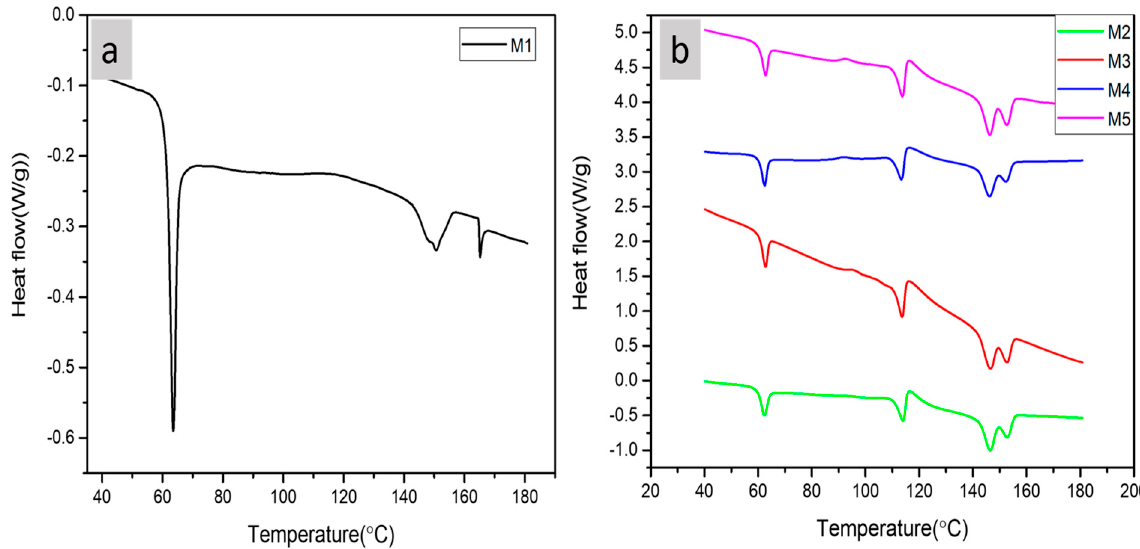
Figure 4. DSC of ( a ) PLA and ( b ) PLA-PBS, PLA-PBS-MCC composite films. This endothermic peak values for PBS and MCC reinforced composites remain approx- imately contact however fluctuates to some degrees by the increase in MCC content. This endothermic peak indicates the disorder in the structure. The transition peak of PLA(M1) is obtained at 64 and on further addition of PBS and MCC in case of M2, M3, M4,